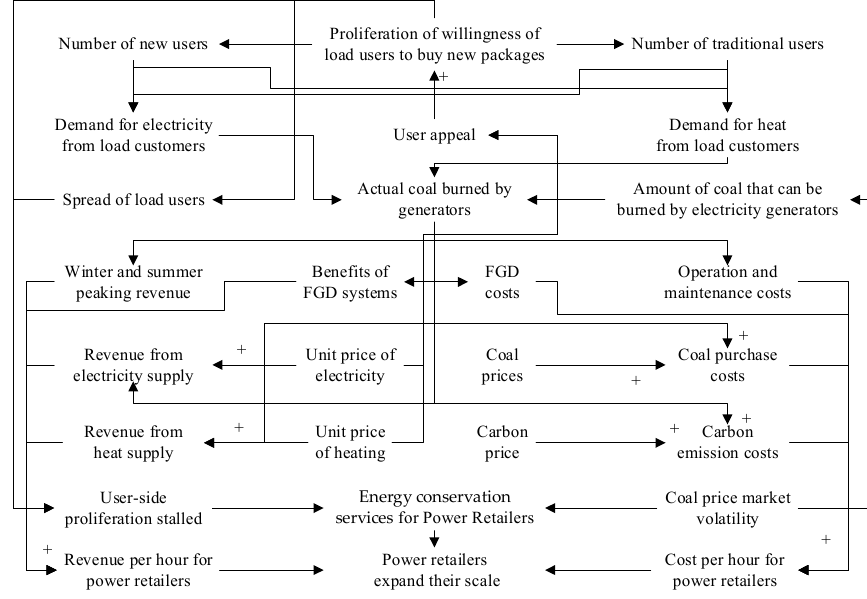
Figure 3. Causal loop diagram.